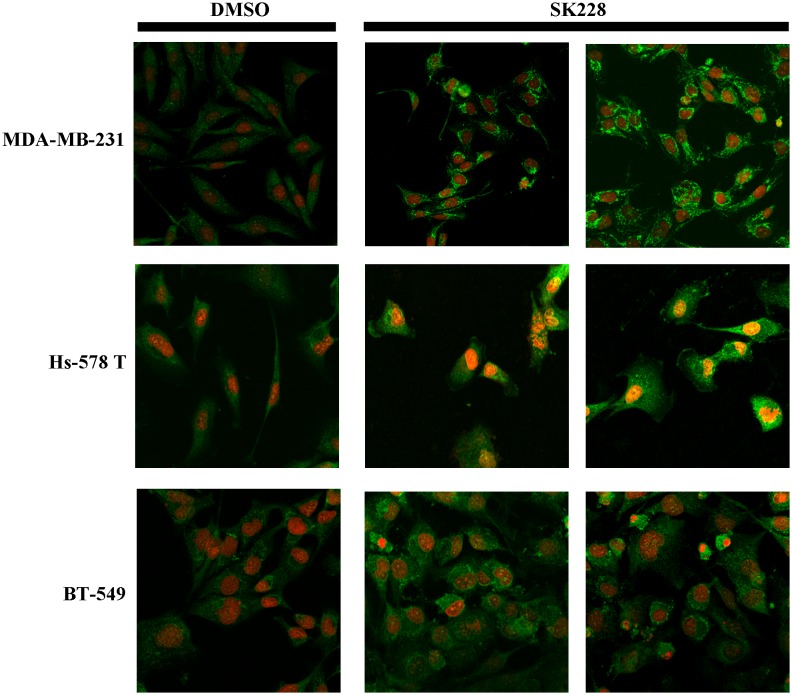
E-cadherin becomes distributed in the cytoplasm closer to the cell membrane after SK228 treatment.Immunofluorescence staining results shows that E-cadherin is induced and distributed in the cytoplasm closer to the cell membrane after SK228 treatment.